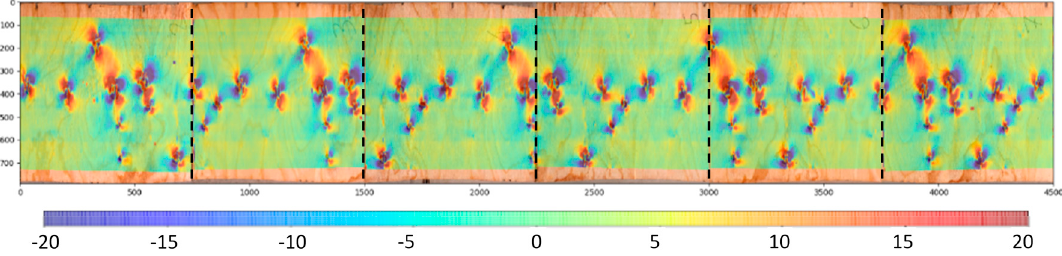
Figure 3. Fiber orientation (°) measured by the scanner and superimposed on the color picture for the first log ribbon.